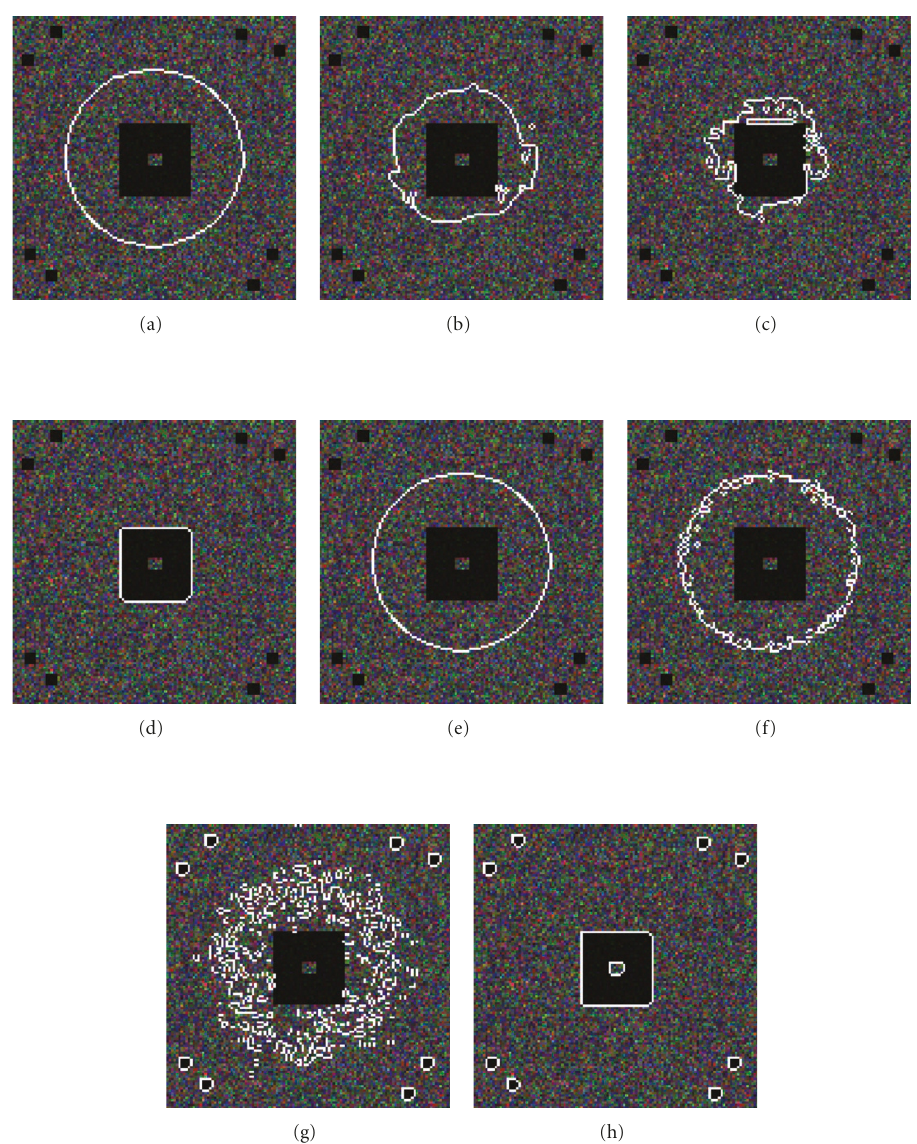
Figure 2: Comparison of 4-look synthetic data object segmentation. (a)–(d) Segmentation by the method in [10]. (e)–(h) Segmentation using our method with global stationary minimum, μ = 2, α =